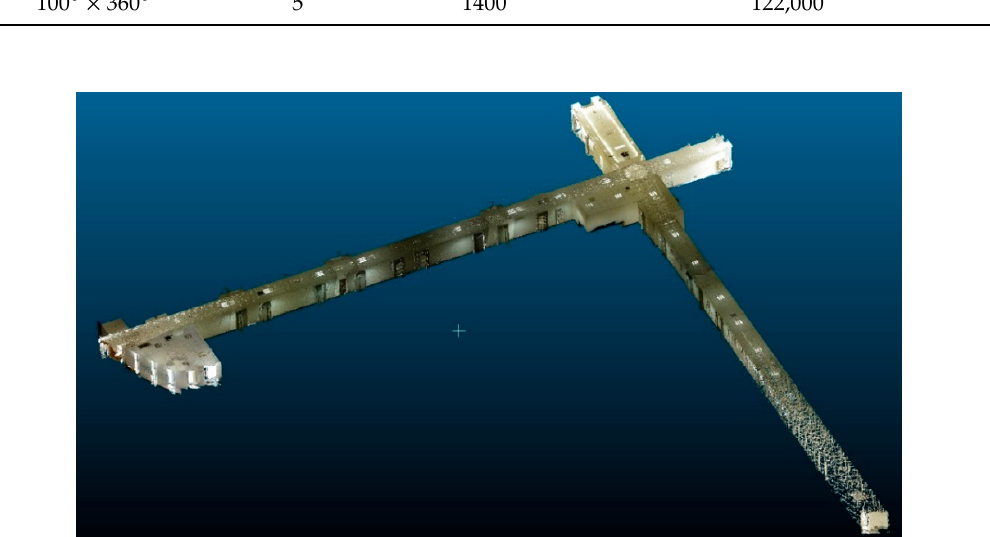
Figure 3. Registered LiDAR point cloud from multiple scans.